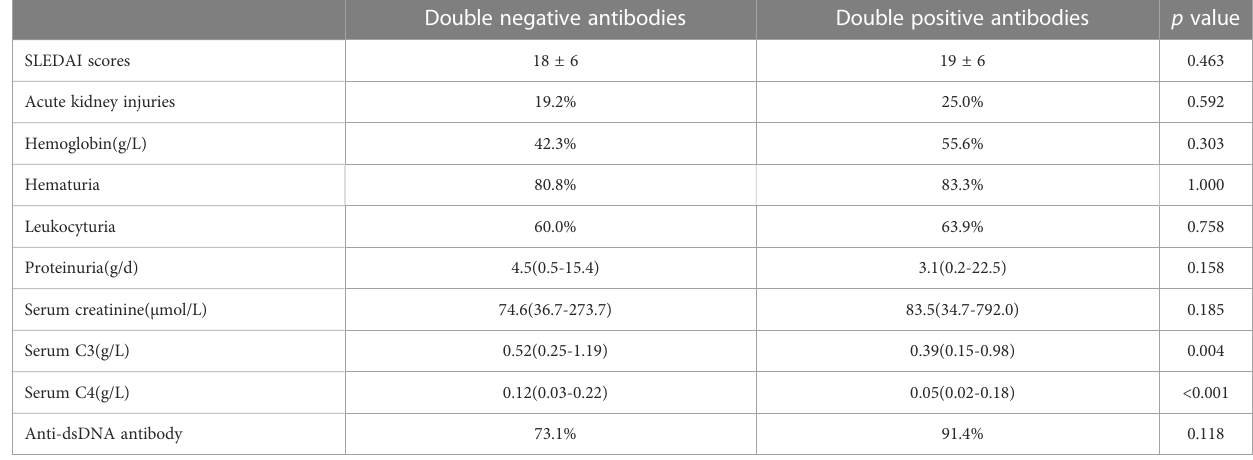
TABLE 4 Comparisons of clinical manifestations of patients with and without double positive antibodies. Double negative antibodies